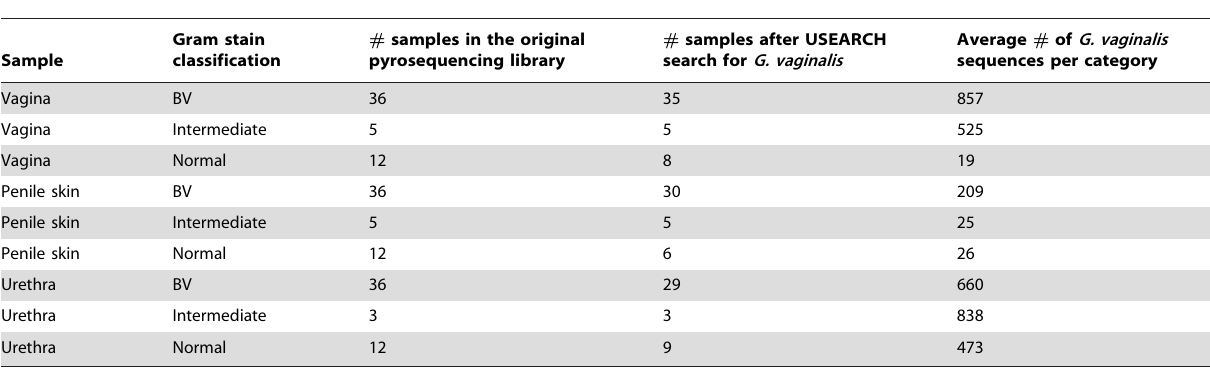
Table 1. Pyrosequencing analysis and USEARCH results